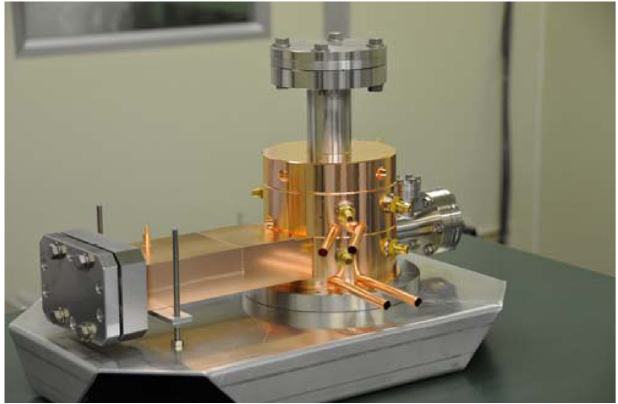
FIG. 7. Measured dark current for the old and new rf guns under similar input power conditions. The new gun shows less dark current than the old gun while maintaining higher quantum efficiency.